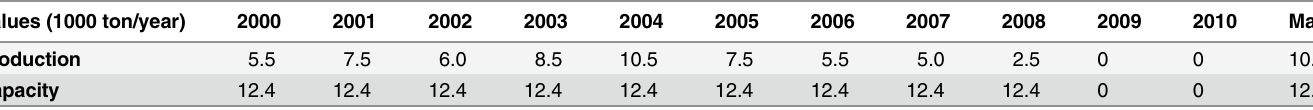
The final product-specific capacity for each facility was determined using the maximum pro- duction value for the 10-year period for which data was purchased. It was assumed that a facility was operating at 85-percent capacity in the year with the highest production (based on utiliza- tion rates provided in the ICR). This value represents the maximum amount of each product a facility can make without making a process change or upgrading equipment. Capacity for a facil- ity was reported as “ 0 ” for years which production values were “ 0, ” as these periods represent pe- riods after a mill was closed, stopped producing a particular product, or before obtaining equipment to produce the specific product. An example of the calculations are shown in Table 2. For integrated facilities, pulp production and pulp capacity were calculated using the pro- cess flow diagrams for those with available data. For pulp production, pre-digester and Table 2. Production capacity example.